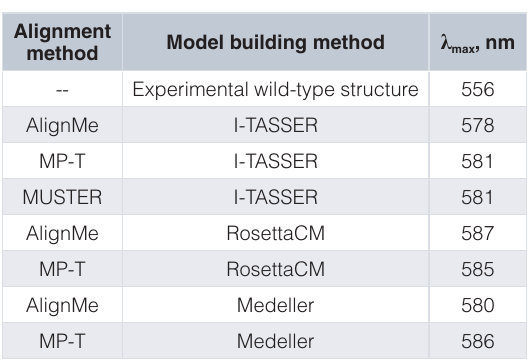
Table 1. Absorption spectrum maximum of achaerhodopsin-3 for different models.